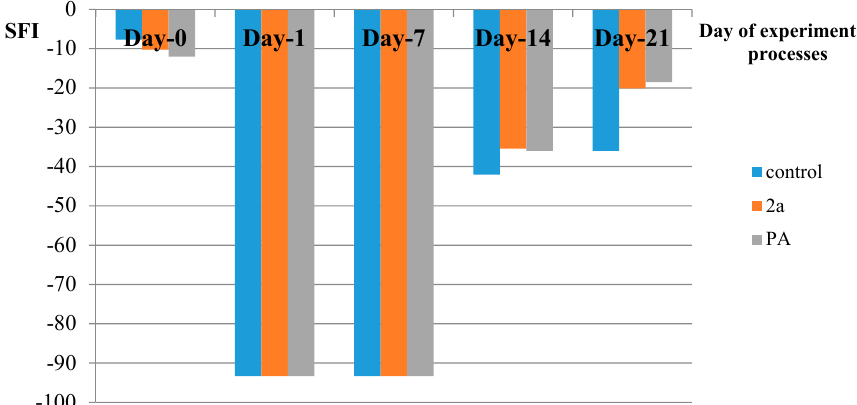
Figure 6. Sciatic Functional Index (SFI) (S.D. <